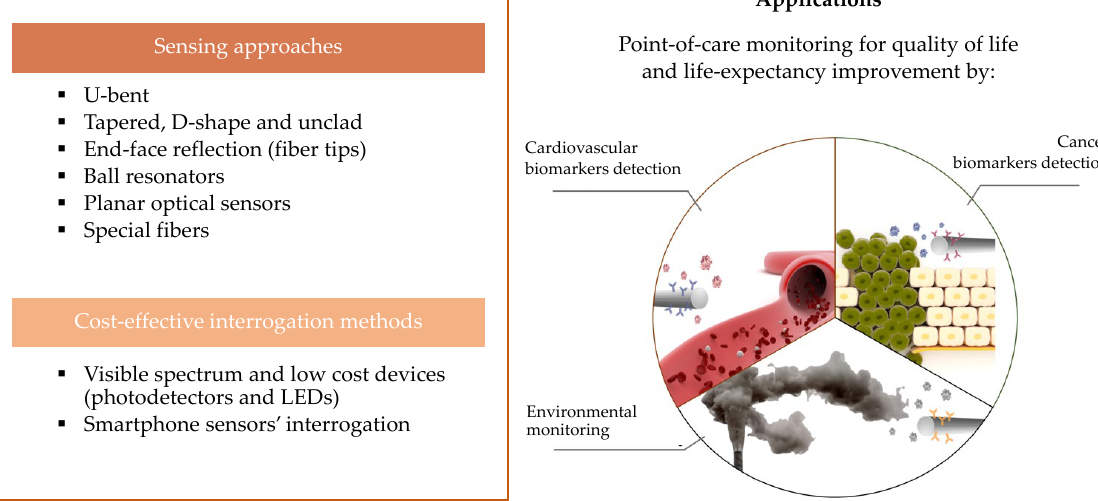
Figure 1. Schematic illustration of the main contents of this review.